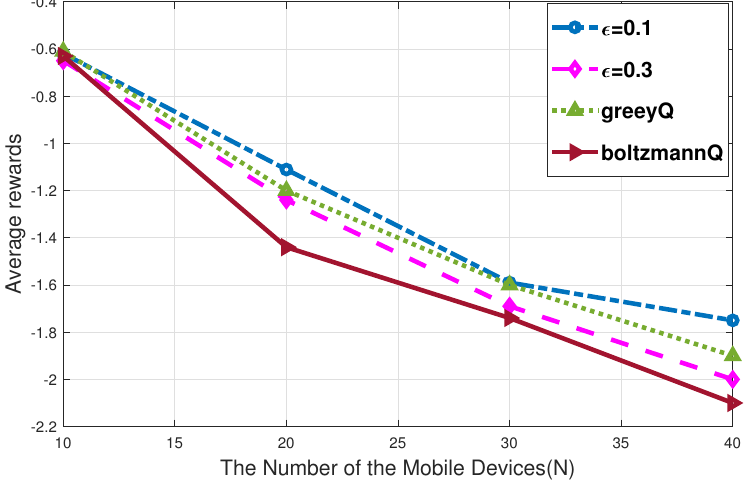
Figure 6. In the case of v = 2 m/s, H = 15 m, the impact of different selection strategies on system